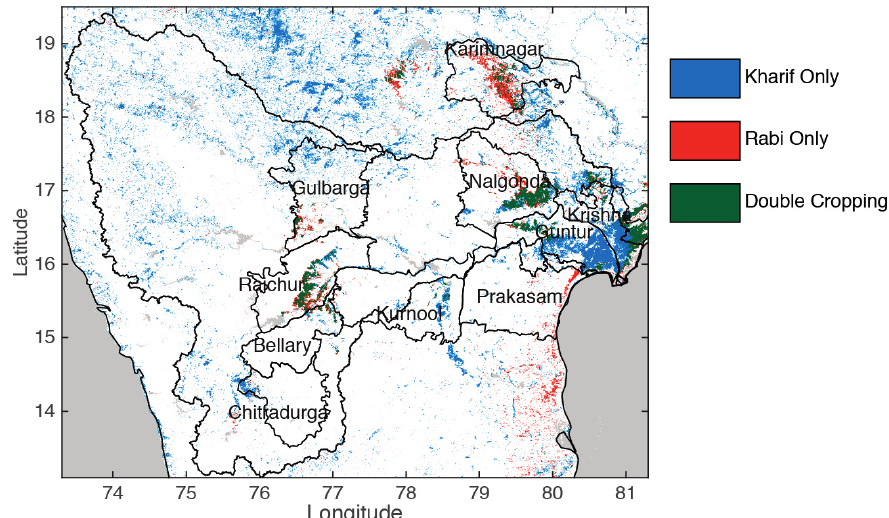
Figure 9. Spatial distribution of Kharif and Rabi paddy rice areas derived using MODIS 500-m datasets in the Krishna River Basin during 2006–2007. Boundaries of the districts chosen for statistical evaluation (used in Section 4.7) are